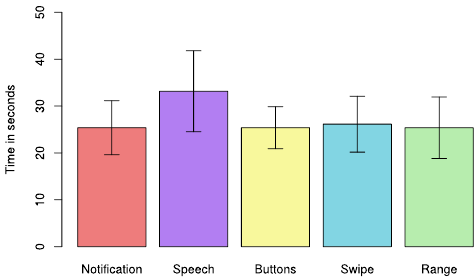
Fig. 4. Time needed by the participants for entering a value using the different methods. Error bars show the 95% confidence interval.